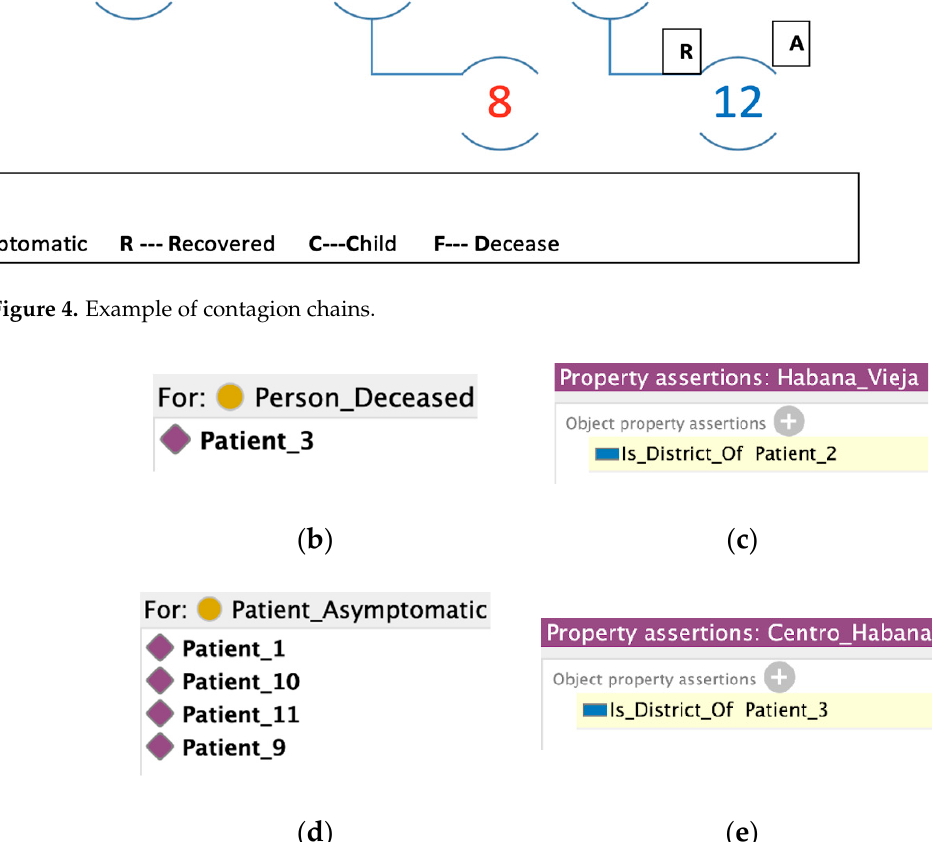
Figure 4. Example of contagion chains.